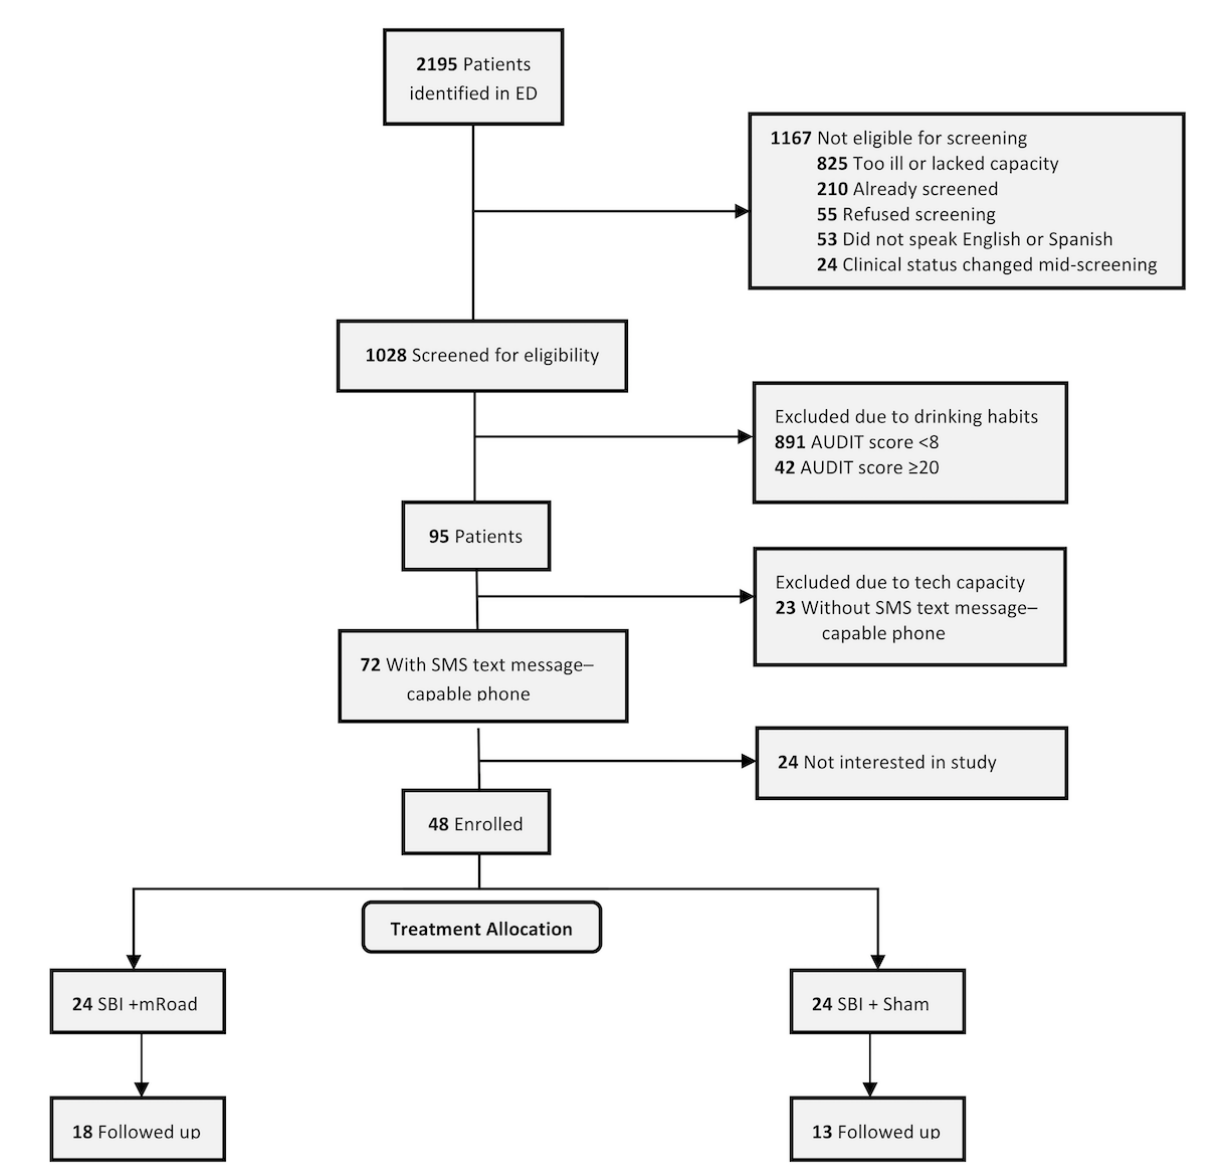
Figure 2. Flow diagram of the